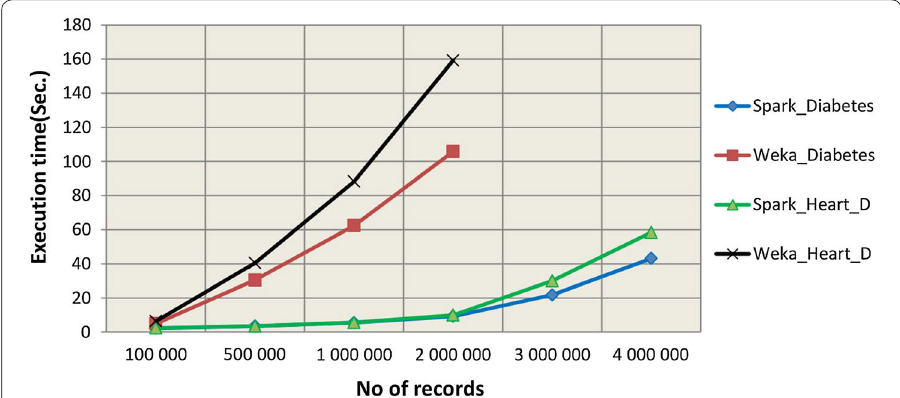
Fig. 9 Execution time comparison of DT using Spark and standard DT: time taken to build model